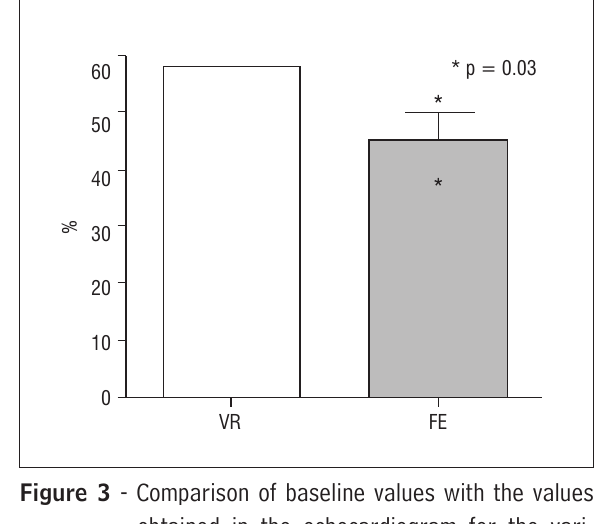
Figure 3 - Comparison of baseline values with the values obtained in the echocardiogram for the vari- able Left-ventricular ejection fraction * (LVEF), where p = significance level Source: Research data. Table 1 - Comparison of normal baseline values with the values obtained in the